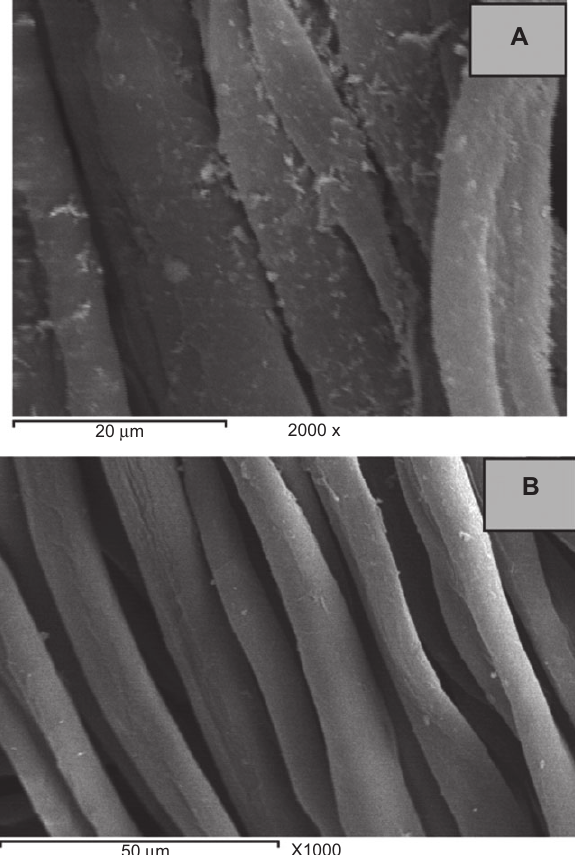
Figure 5 SEM pictures of the pristine cotton fabric (B) and cotton fabric treated (A) with ZnO/CMCTS bionanocomposite.